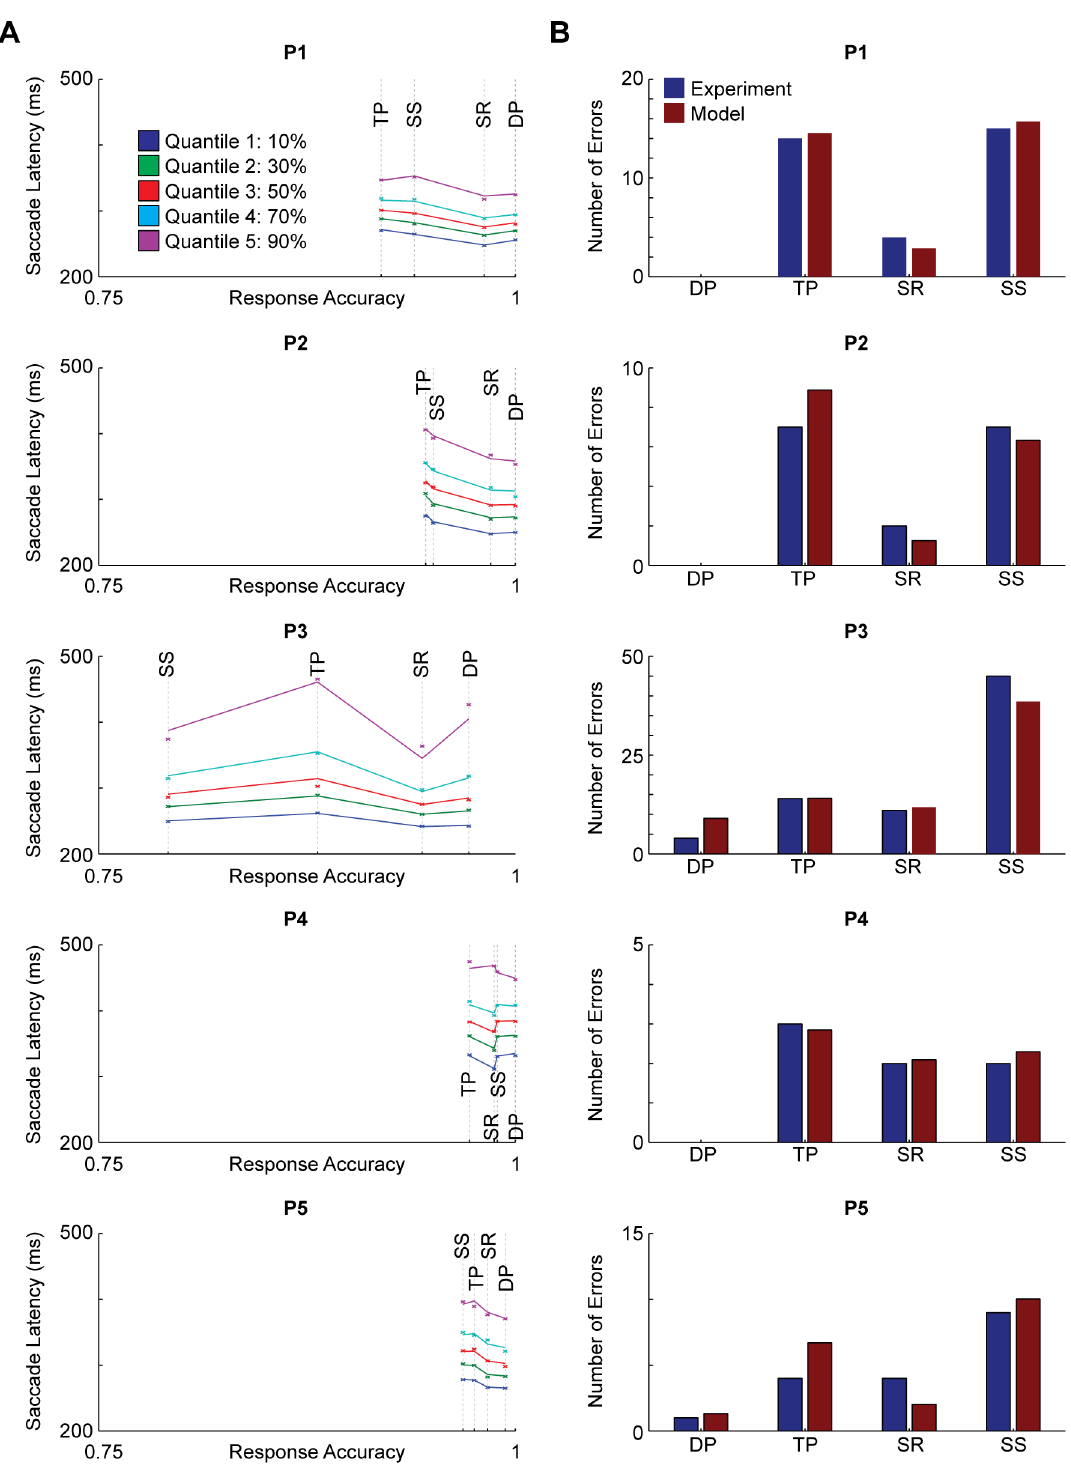
Figure 3. Model Goodness of Fit. (a) Quantile probability plots for the correct trials. These compare reaction time distributions from the model (lines) with empirical reaction times (x’s) for every experimental condition. (b) Number of error trials generated by the model (red) is compared to the number of empirical error trials (blue) for every experimental condition. doi:10.1371/journal.pone.0089996.g003 support the model comparison results; a change in drift rate is We also tested whether there is a difference in both boundary unlikely the cause of the DPE and POP. separations and non-decision times between the DPE and POP conditions, that is, whether a DPE = a POP and T DPE = T POP . The best